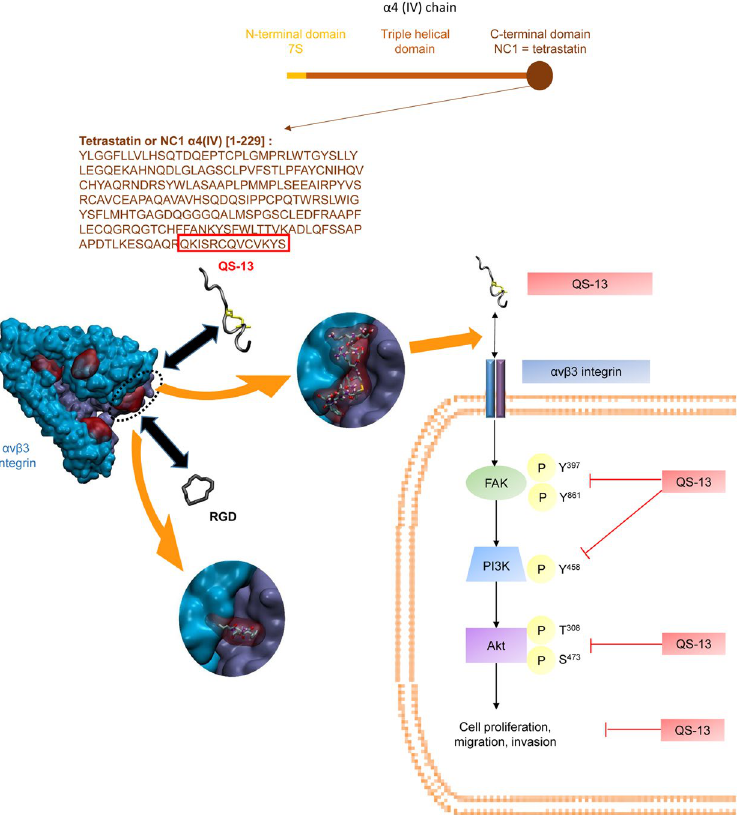
Figure 7. Summary diagram of QS-13 binding and mechanism of action. The QS-13 peptide is located at the C-terminal extremity of the Tetrastatin or Non Collagenous (NC)-1 domain of the α 4 chain from type IV collagen. QS-13 conformation was deducted from Molecular Dynamics simulation. Molecular docking experiments suggest the presence of 5 preferred areas of interaction (PAI-1 to PAI-5); 4 of them appear in red on α V β 3 integrin that is represented in blue and violet. Magnifications of PAI-1 allow to visualize QS-13 binding (up) or RGD binding (down) [20]. This explains that RGD pre-incubation abolishes QS-13 interaction with α β V 3 at the cell surface. QS-13 binding inhibits cell proliferation, migration and invasion through the FAK/